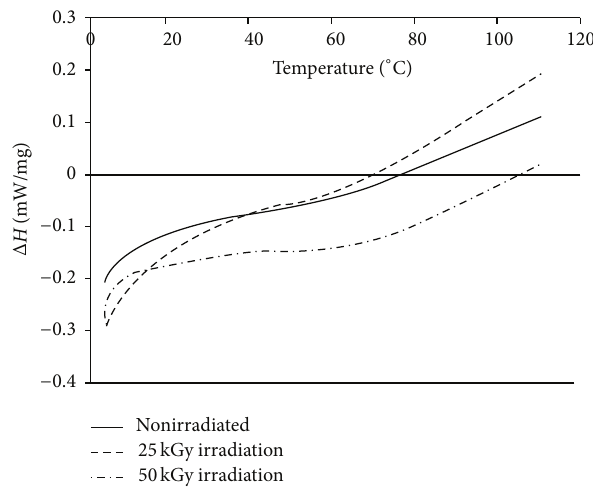
Figure 8: DSC diagram of hydroxyapatite irradiated with 0, 25, and 50 KGy dose of gamma irradiation.